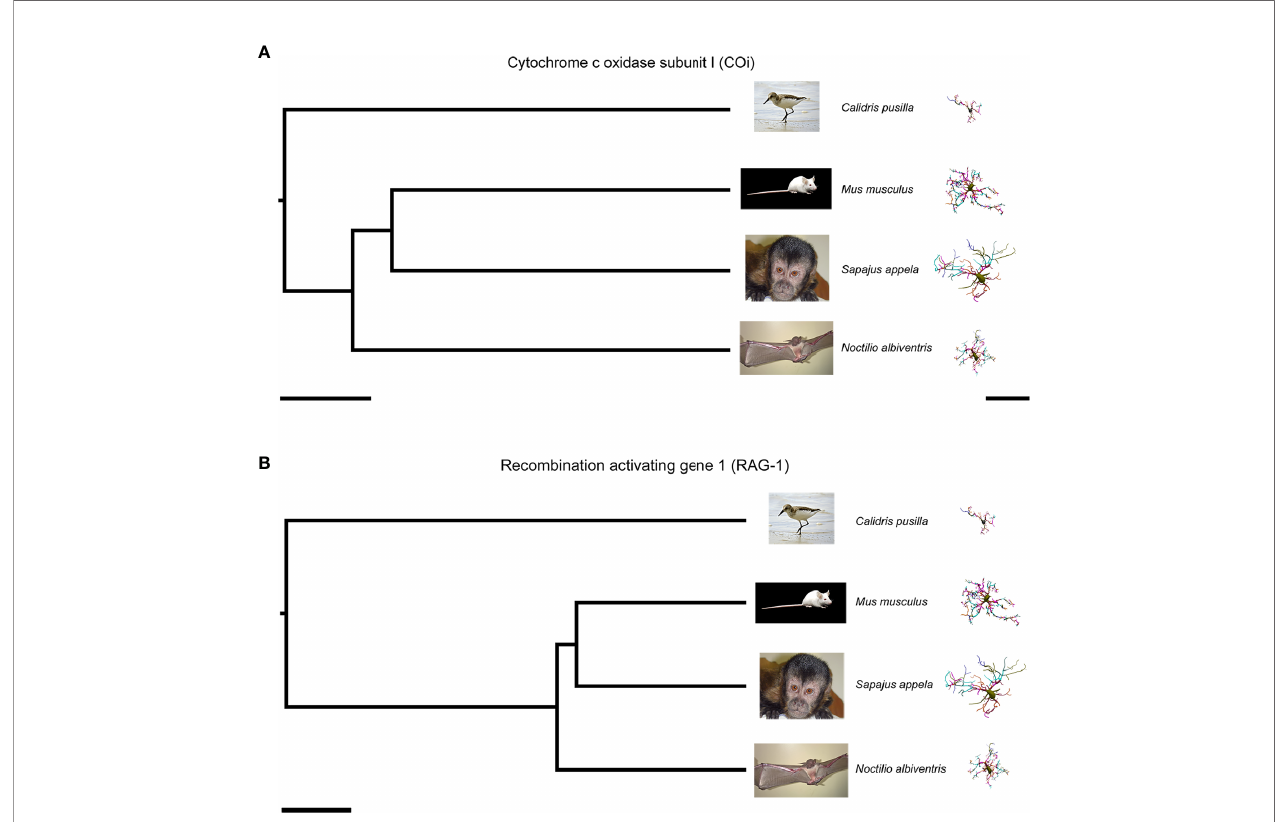
FIGURE 3 | Phylogenetic trees based on the DNA sequences of the mitochondrial COi (A) and nuclear (B) genes for Calidris pusilla , Sapajus apella , Mus musculus and Noctilio albiventris with corresponding three-dimensional reconstructions of microglia. The representative cell is closest to the “ average ” cell for each species. To select them, the distance matrix was used to obtain the sum of the distances of each cell in relation to all the others. We assumed that the cell that best represents each group would have the least sum of distances. See Table 2 for molecular markers used for phylogenies based on COi and RAG-1. COi, cytochrome oxidase subunit 1; RAG-1, Recombination activating gene 1. Scale bars for phylogeny A = 20Ma, B = 30Ma; scale bar for microglia reconstructions = 40